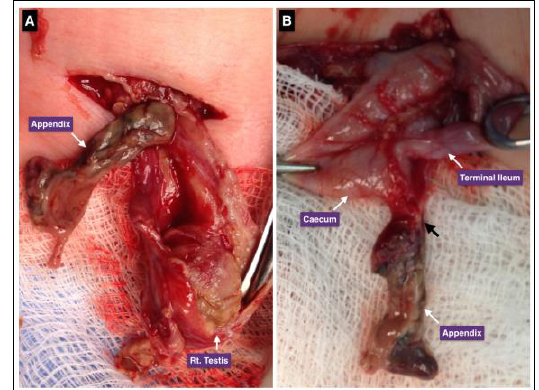
Figure 2: Surgical exploration through right inguinal inci- sion. A). Gangrenous appendix in the right patent proces- sus vaginalis (opened), right spermatic cord and testis are significantly inflamed B). Further exploration revealed mild- ly congested caecum and terminal ileum and most of the appendix was gangrenous, black arrow indicates the point where the appendix was